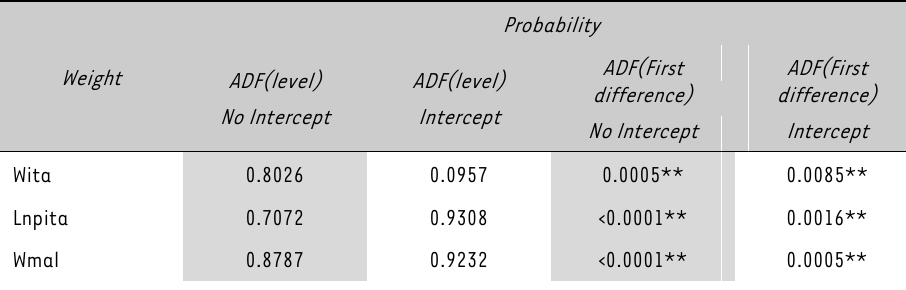
ADF results for USA